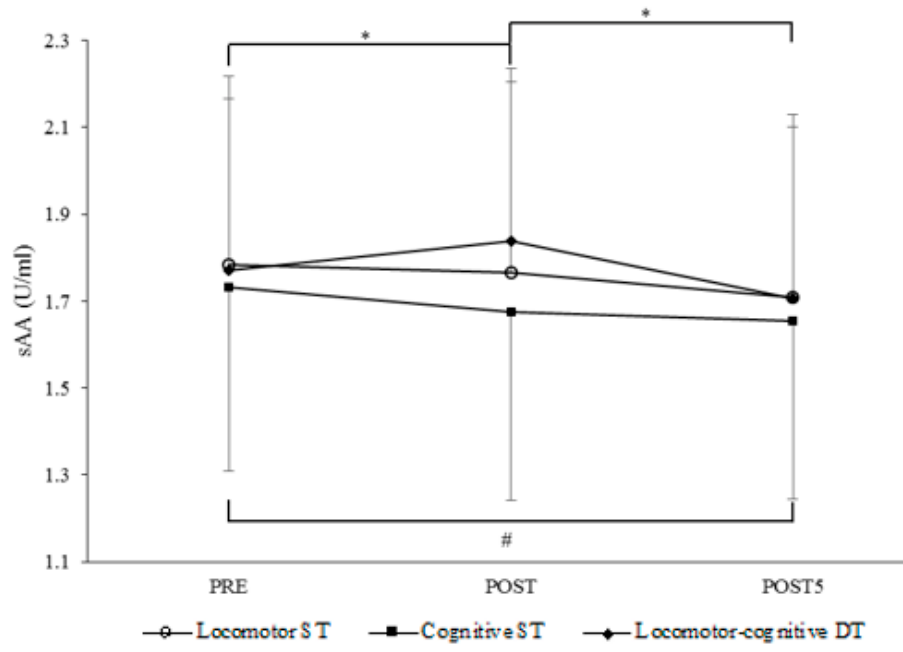
Figure 2 . Differences in salivary α -amylase (sAA, log-transformed) sampled before (Pre), immediately and 5 min after (Post, Post5) task performance separately for the three task conditions. Locomotor ST = walking task at habitual walking speed (HWS). Cognitive ST = random number generation (RNG) task. Locomotor-cognitive DT = walking at HWS while performing the RNG task. * and # = significant ( p < 0.01) differences for locomotor-cognitive DT and for cognitive ST, respectively.